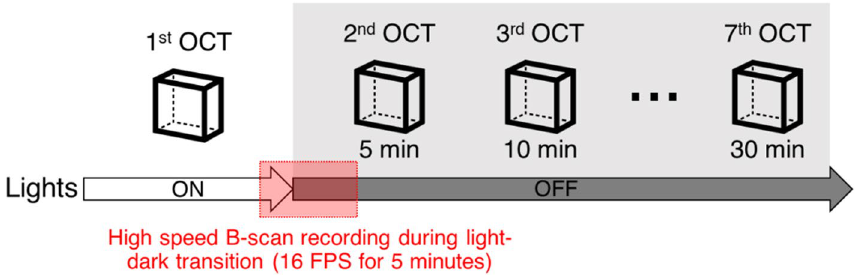
Figure 8. Image acquisition flow chart. The first OCT volume was acquired under ambient light conditions. After lights off, the second to seventh OCT volumes were sequentially acquired every 5 min up to 30 min. In between the first and second OCT volume acquisition, high-speed B-scan recording was performed to monitor retinal response during a light–dark transitional